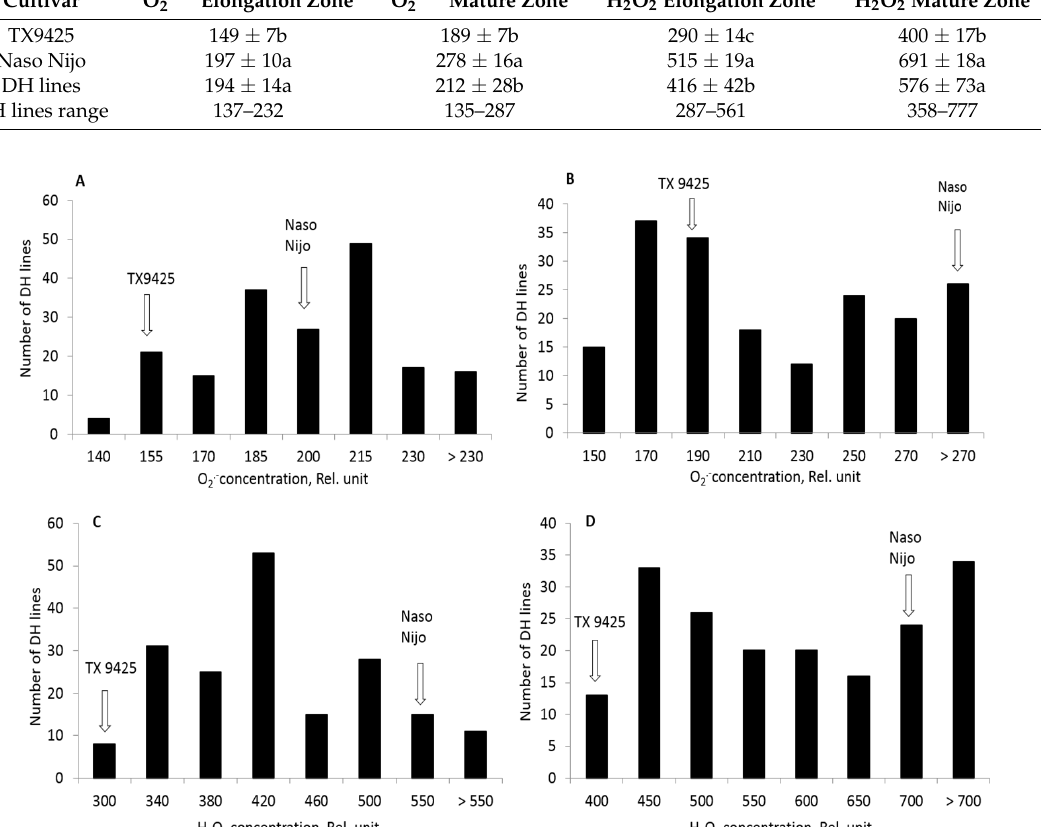
Figure 3. ( A , B ) The frequency distribution for superoxide (O 2 •− ) and ( C , D ) hydrogen peroxide under hypoxia (0.2% agar) stress of DH lines derived from a cross between TX9425 and Naso Nijo.